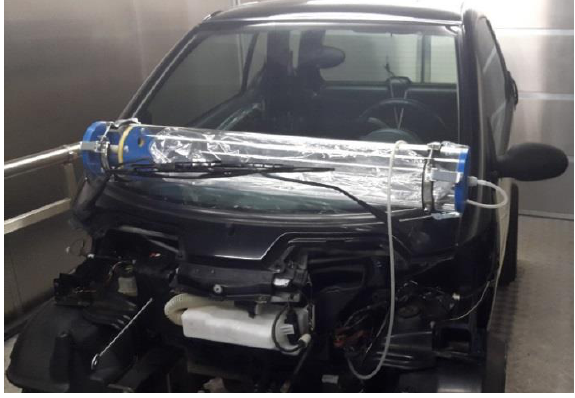
Fig. 5. Exterior of the tested vehicle with sampling probe AVOCs Samples were collected by YEARS aspirator, model ASP-3 II, flow rate adjusted to 30 dm3/h, the amount of gas collected is 10 dm 3 . The gas was absorbed on active carbon Anasorb® SKC CSC. Activated carbon is poured into a glass tube of 5 cm 3 and later it is emerged in 2 cm 3 of carbon disulfide. The BTX in the samples was determined by gas chromatography according to the test procedure of the Emission Research Laboratory No. 1/2010 using the gas chromatograph Varian 450 – GC with flame ionization detector (FID), and a column Varian VF-WAXms 30 m × 0.25 mm ID DF: 0.25 um. The work was performed at the set temperature of the column 373 K (110°C), the dispenser 523 K (250°C) and detectors 423 K (150°C). YEARS aspi- rator, model ASP-3 II, flow rate adjusted to 30 dm 3 /h, the amount of gas collected is 10 dm 3 , collected samples. The gas was absorbed on active carbon Anasorb® SKC